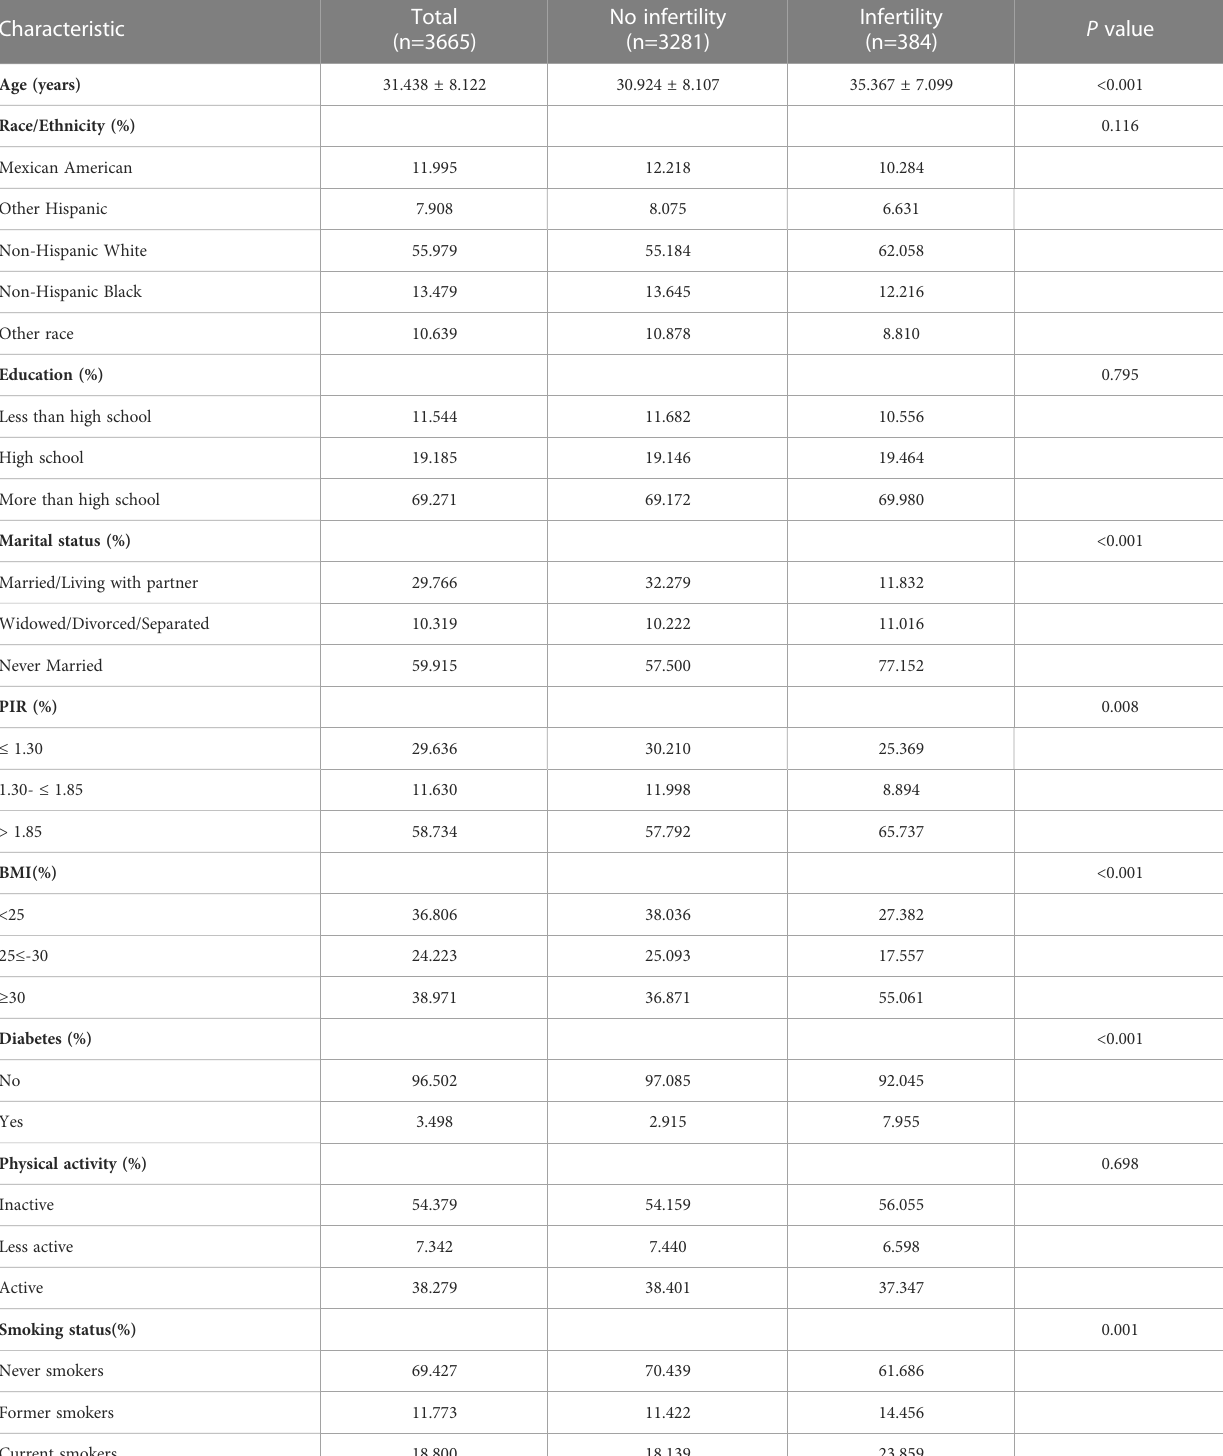
TABLE 1 Characteristics of the study population, National Health and Nutrition Examination Survey (NHANES) 2013 –